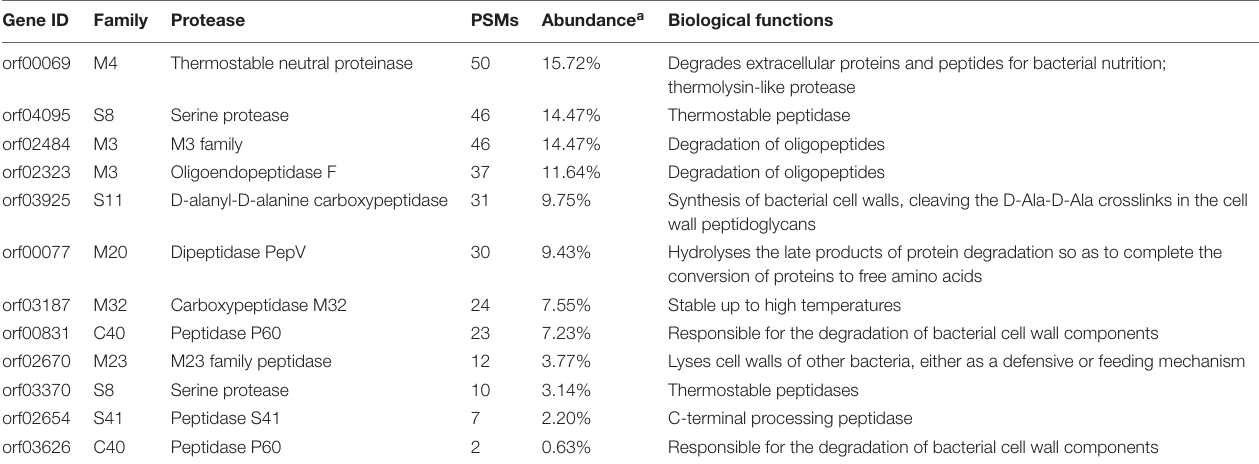
TABLE 4 | The extracellular proteases secreted by strain 1A02591 identified by secretome